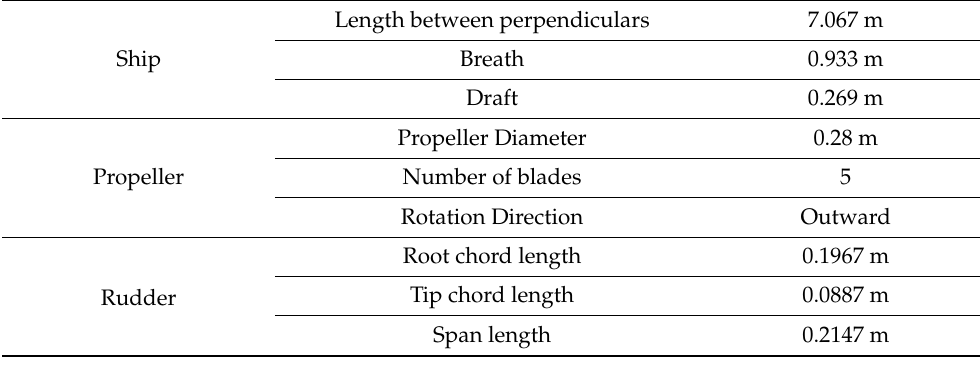
Table 1. Main dimensions of the ship, propeller and rudder models.